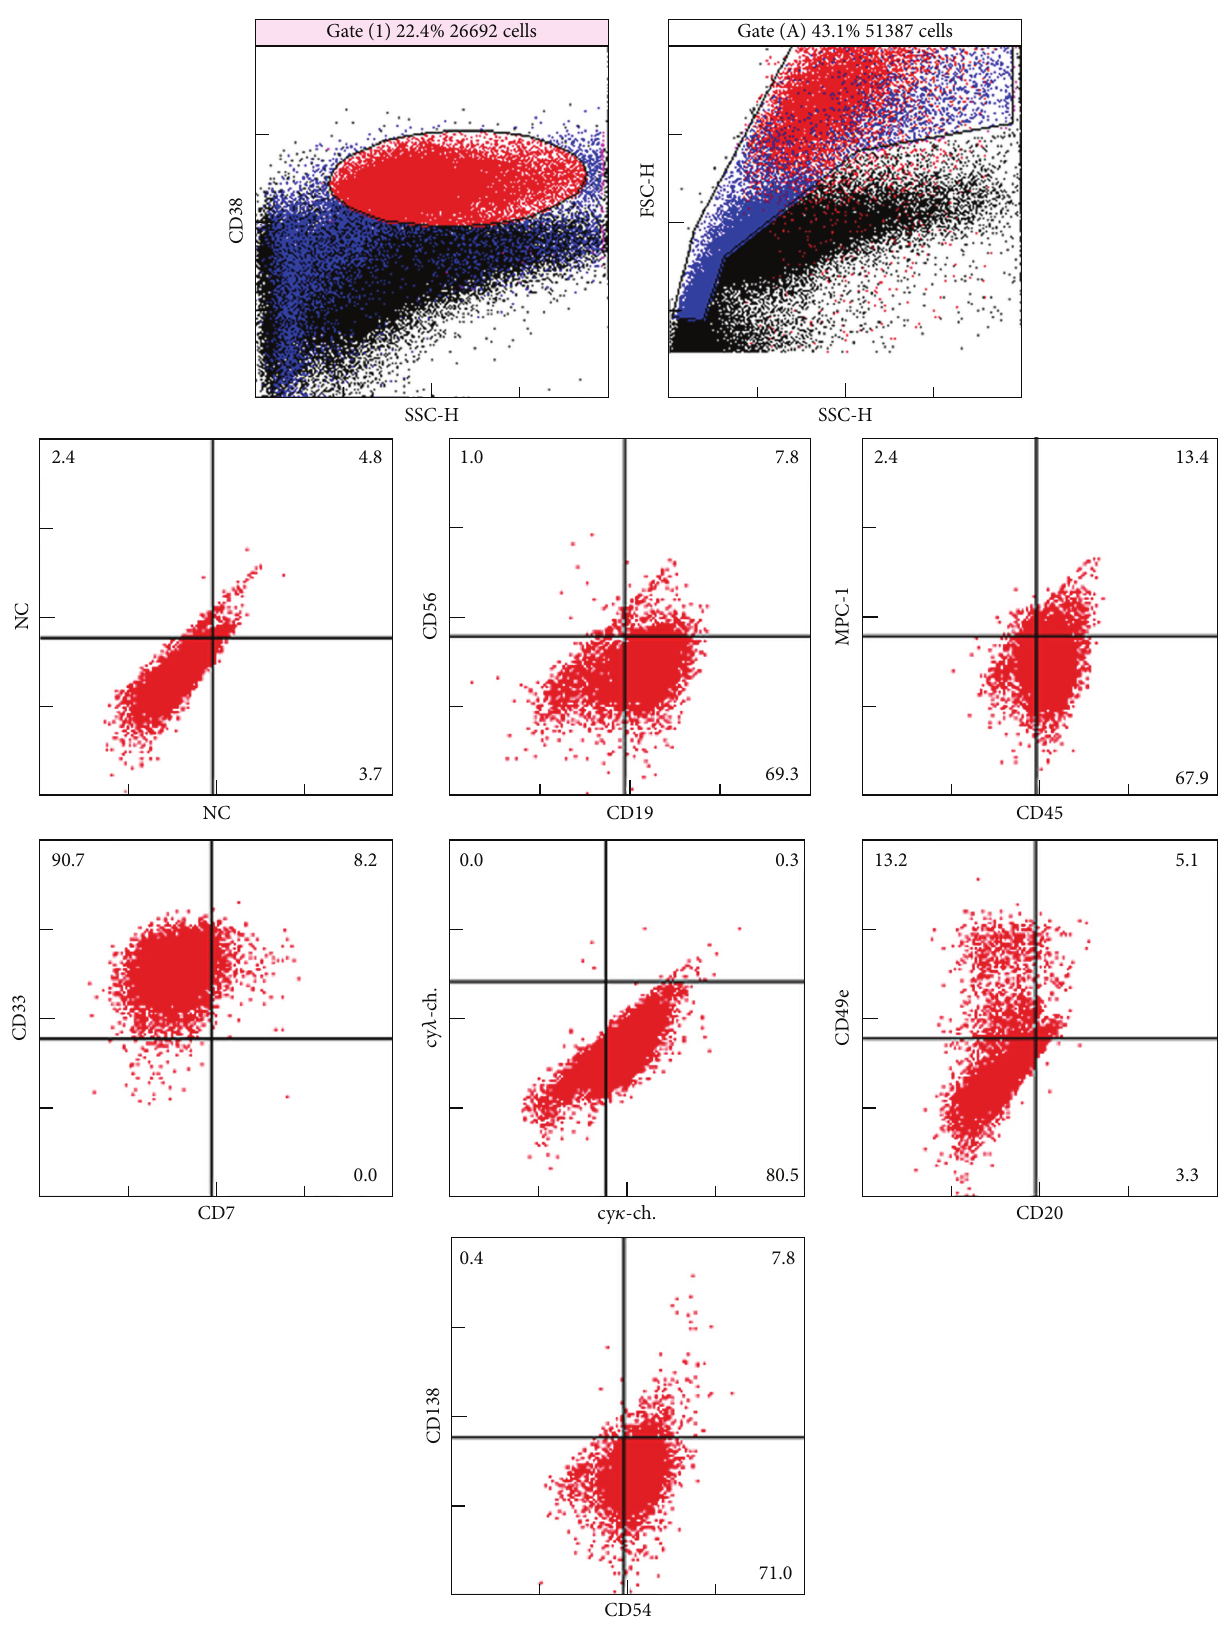
Figure 2: Flow cytometry of bone marrow. CD38 positive cells were positively stained with CD19, CD33, and 𝜅 antigens and negatively with CD138, CD20, and 𝜆